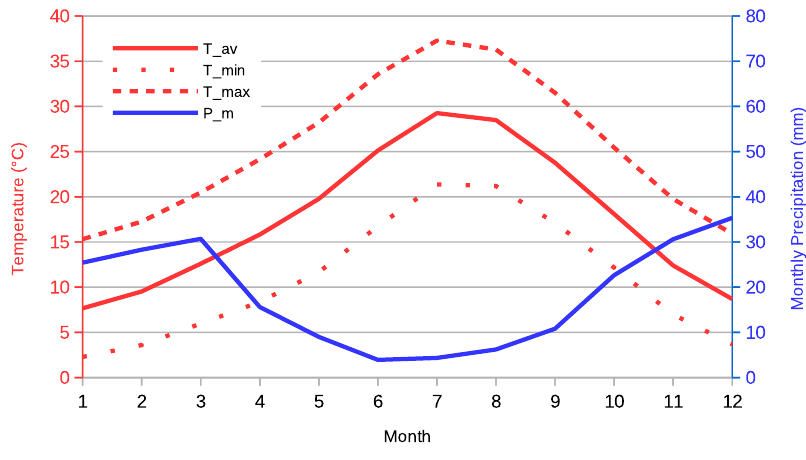
Figure 12. Climograph at Assaragh derived from the NASA Power dataset of monthly temperatures and precipitations from 1984 to 2013.